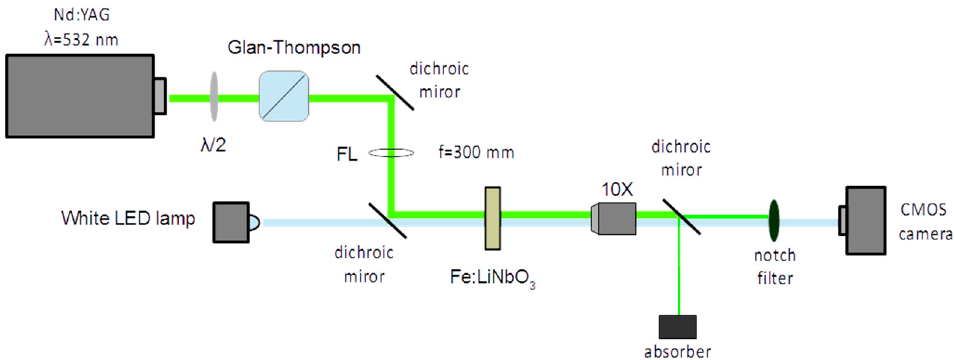
Figure 7. Scheme of the setup developed for experiment of optical trapping on a lithium niobate crystal, with the laser propagating in a plane perpendicular respect to the large faces of the y-cut sample.